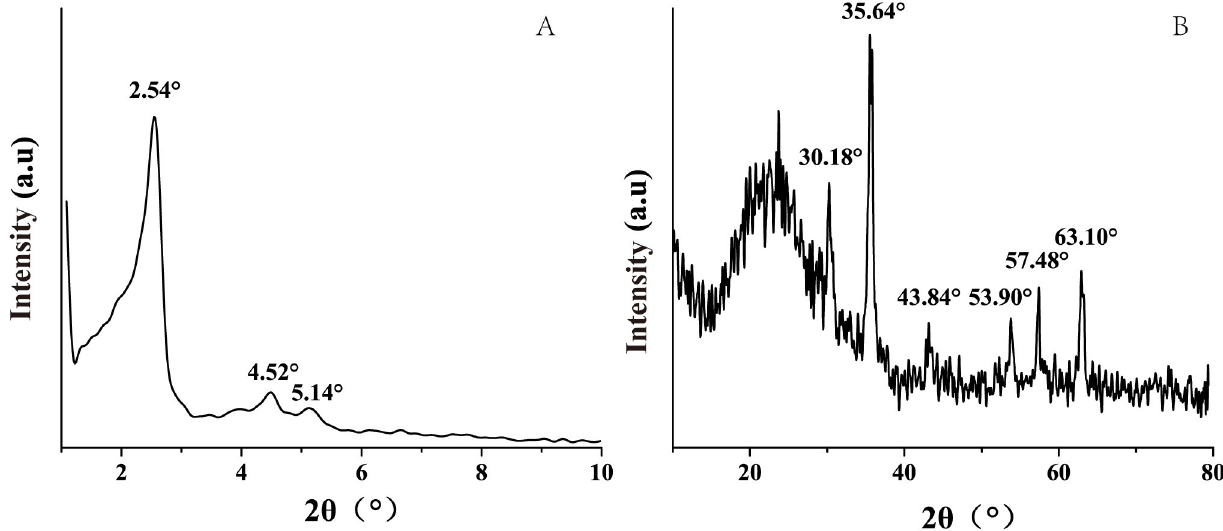
Fig 3. Small angle X-ray diffraction (A) and large angle X-ray diffraction (B) of MMS.